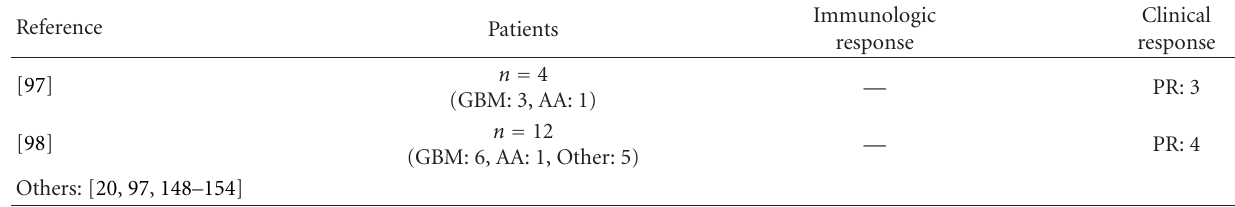
Table 3: Selected clinical trials using cytotoxic T lymphocytes